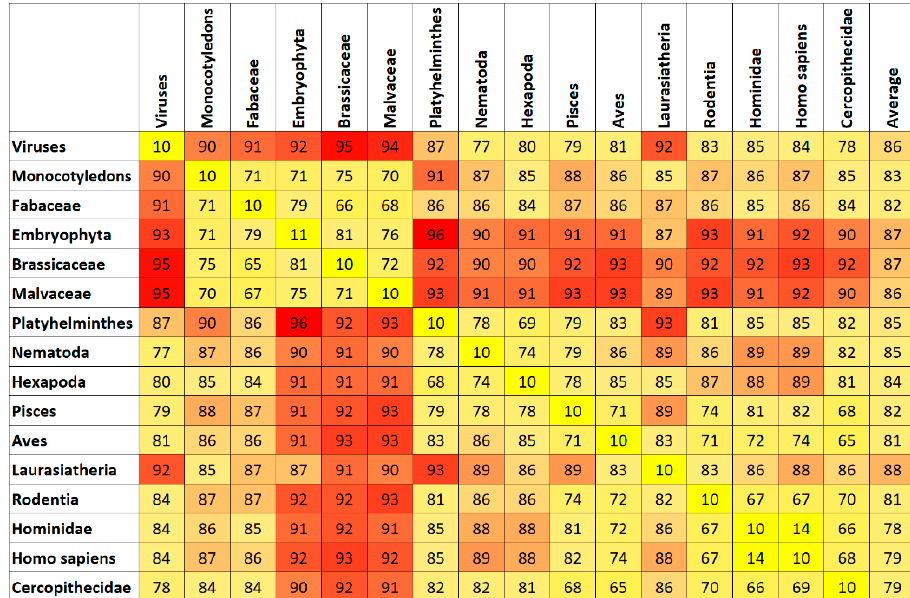
Figure 8. Average accuracy for 100-fold MCCV using a random forest classifier and a split of 80% training and 20% testing employing only secondary-structure-based features. Yellow shades indi- cate lower accuracy, while red shades show higher average classification accuracy.